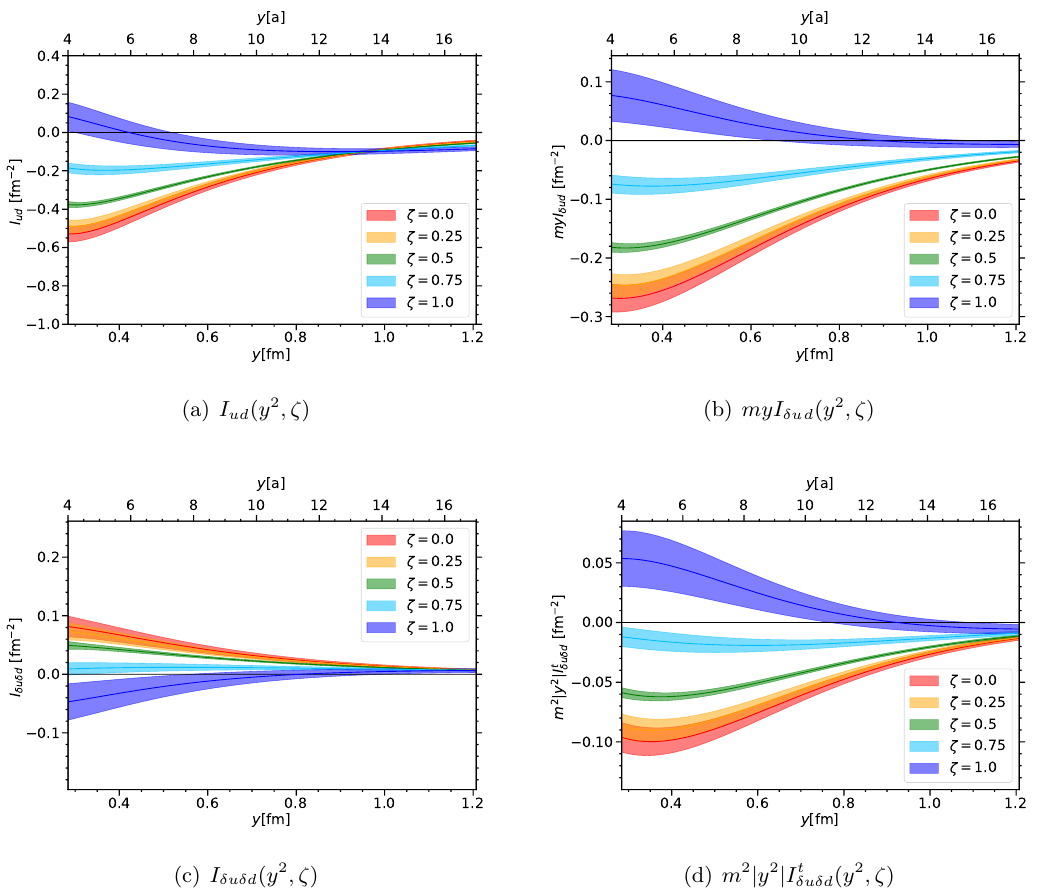
Figure 29 . Mellin moments of skewed DPDs as a function of y , reconstructed from our global fit.